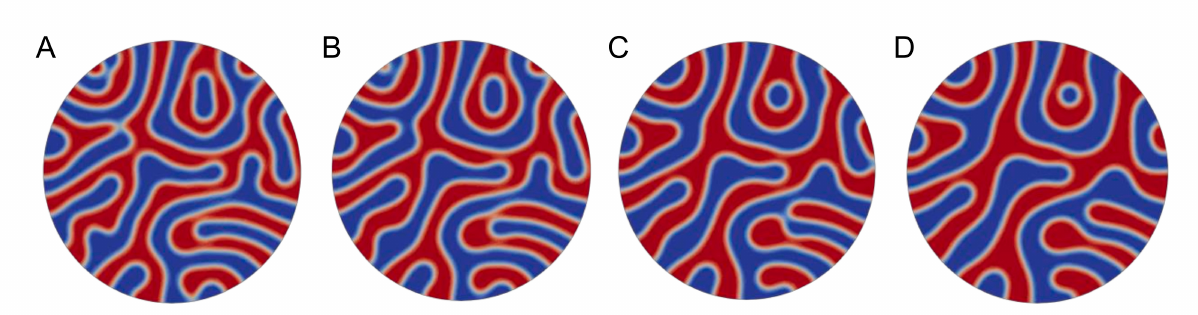
Figure 5. Calcium-free mitochondria simulation by a circle domain with a radius of five. The time step ∆ t = 0.001 for ( A ) t 750 , ( B ) t 1250 ( C ) t 1750 , and ( D ) t 2250 . As shown in Figure 4, merging and splitting of the phase spaces are observed as the simulation time